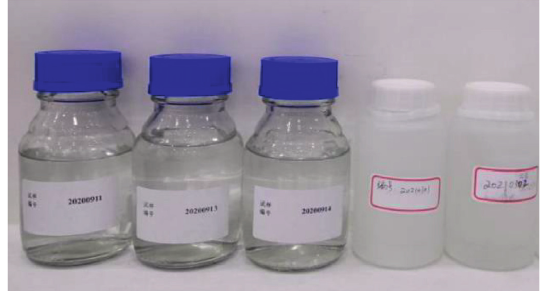
Figure 6: Groundwater samples from the tailrace surge chamber and adjacent drainage galleries. Table 1: Groundwater aggressivity in the tailrace surge chamber.